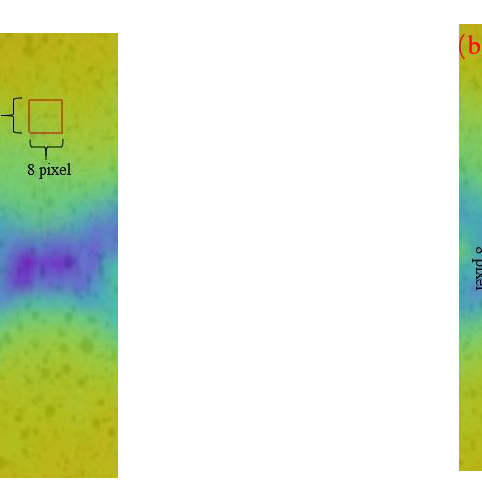
Figure 12. Calculation area of R-value: ( a ) Non-necking area; ( b ) Necking area.